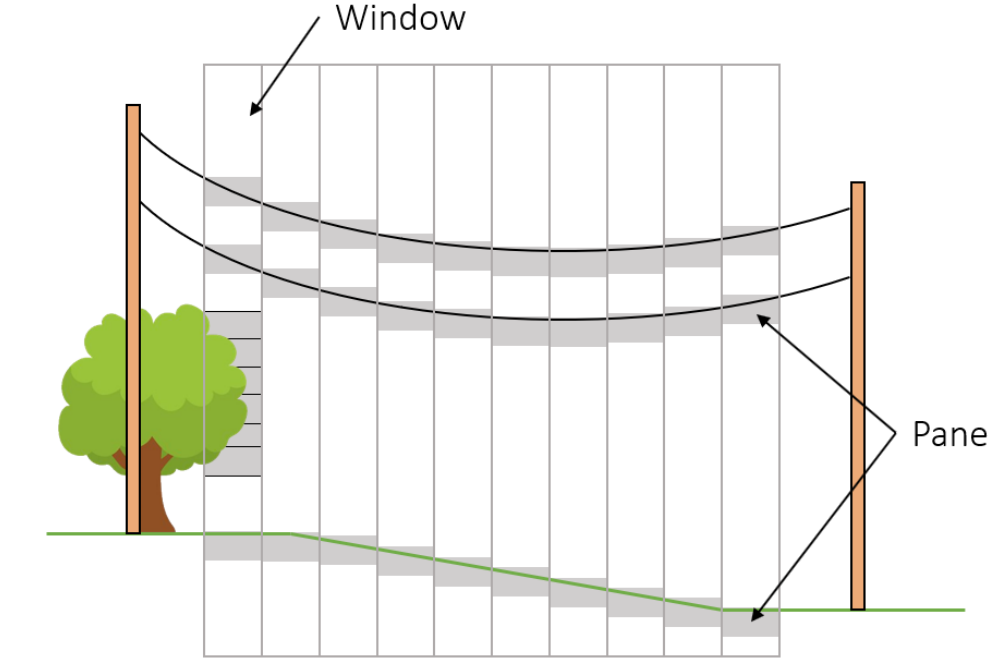
Figure 1. Each window is traversed downwards and new panes are fitted until all points within the window are also included within a